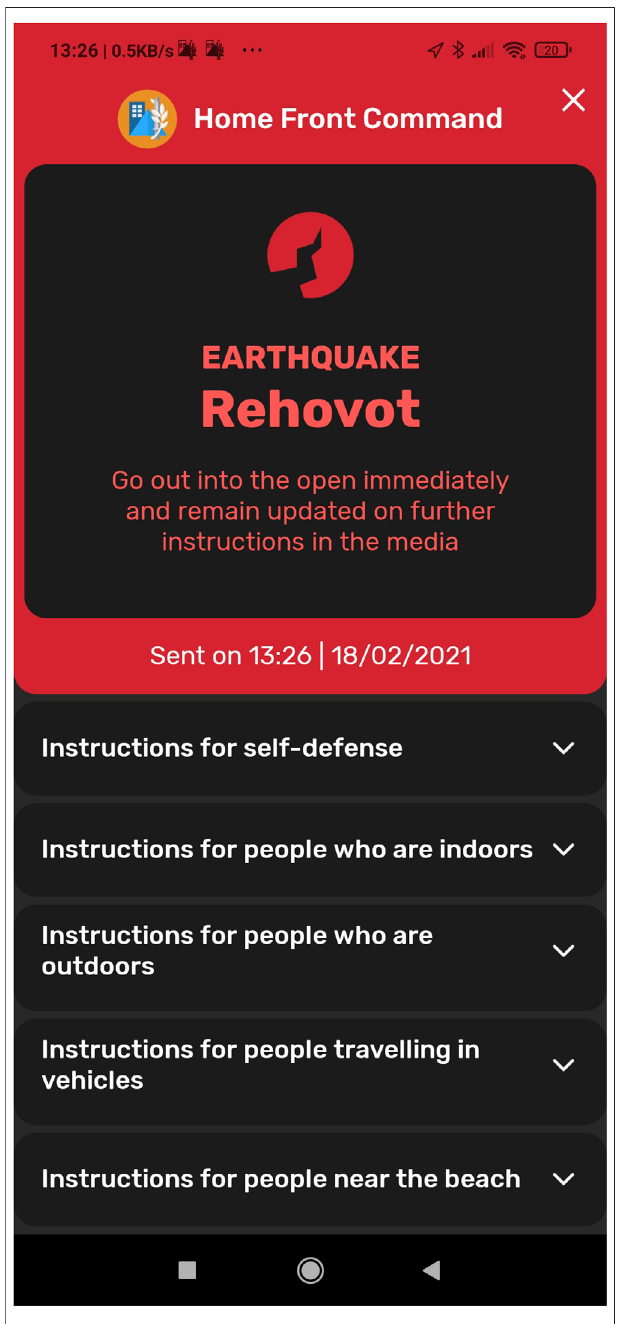
FIGURE 4 | Alert panel screenshot taken from the HCF app. Red frame surrounding dedicated earthquake icon with the name of user place, action instructions, date, time and type of threat (earthquake in this case). A unique alerting sound and additional instructions are also available. Instructions include information on how to react at different places (indoors, outdoors, cars,